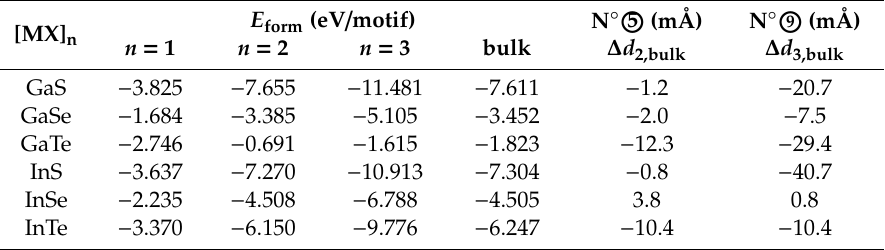
Table 2. Formation energy E form of bulk and of [MX] n slabs when n equals 1, 2, and 3, and di ff erences in the distance ∆ d 2, bulk between M’–X in bilayer and bulk and ∆ d 3, bulk between M”–X’ in trilayer and